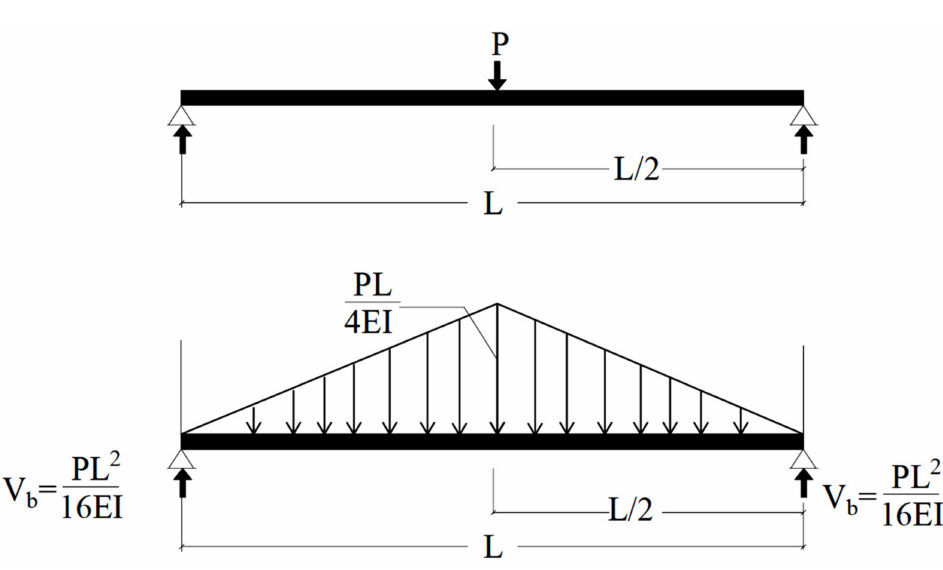
Figure 18. Conjugate beam loaded with M/EI